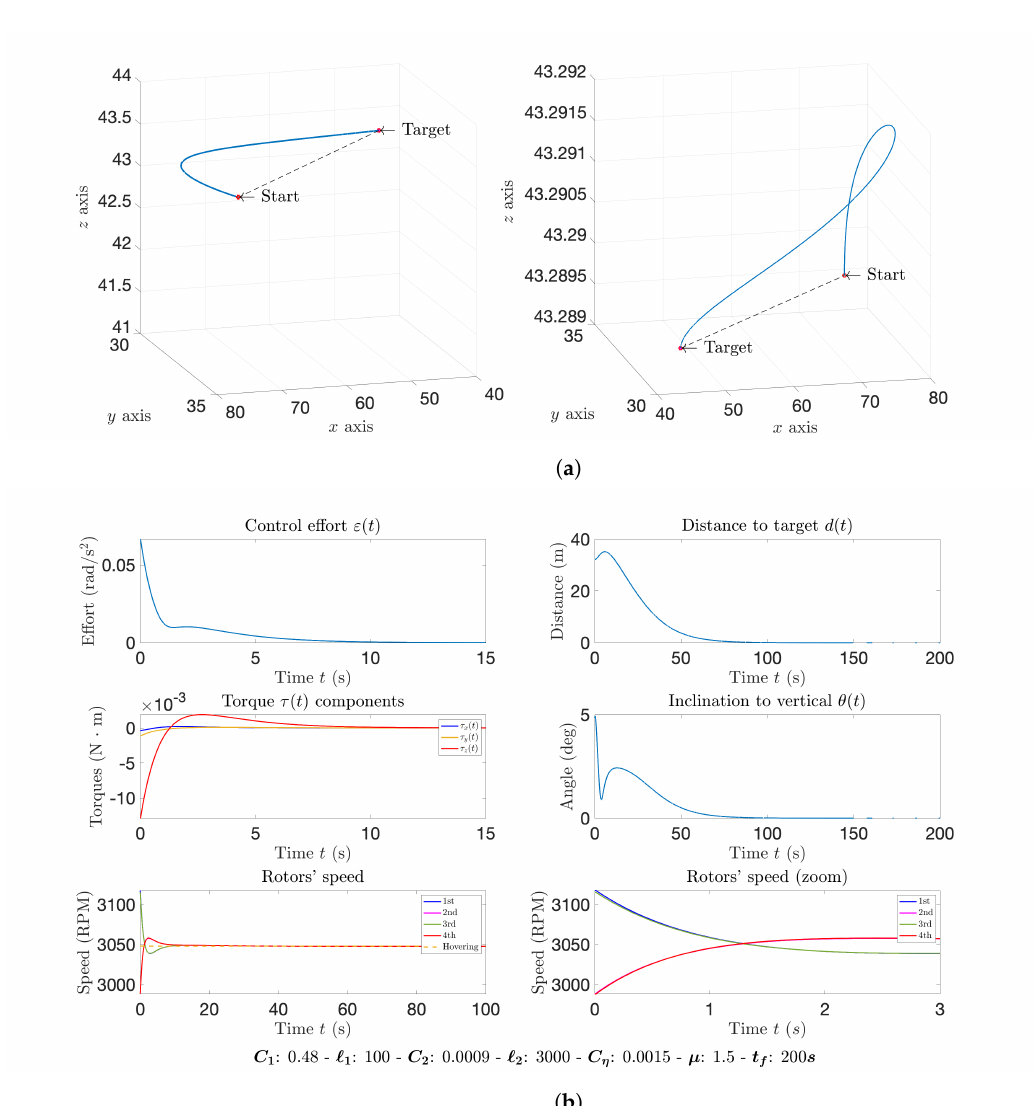
Figure 7. Experiment: Horizontal displacement, random initial conditions. ( a ) Target approaching tra- jectory; ( b ) Control